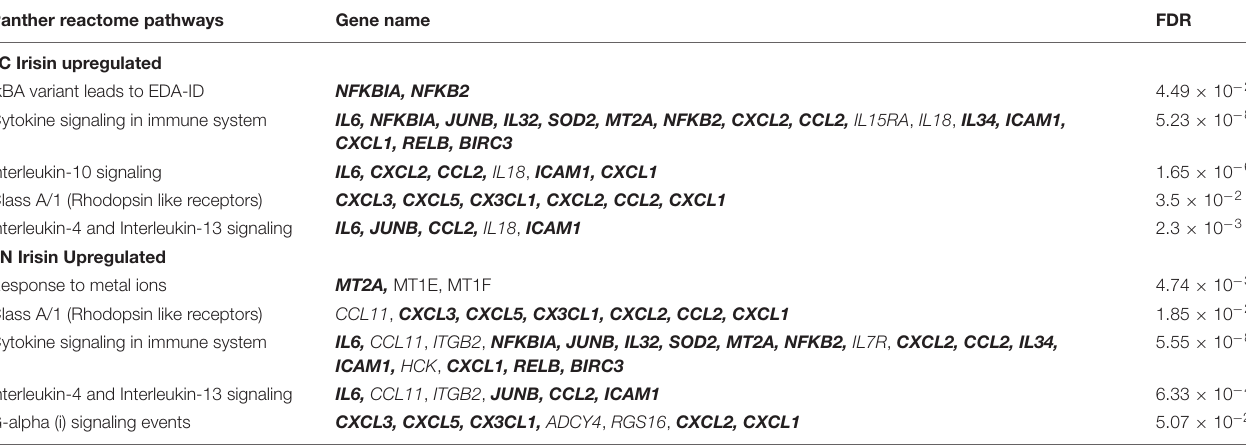
TABLE 1 | Pathways of significantly upregulated genes upon irisin treatment during differentiation of subcutaneous (SC) and deep-neck (DN) derived adipocytes. Panther reactome pathways Gene name FDR SC Irisin